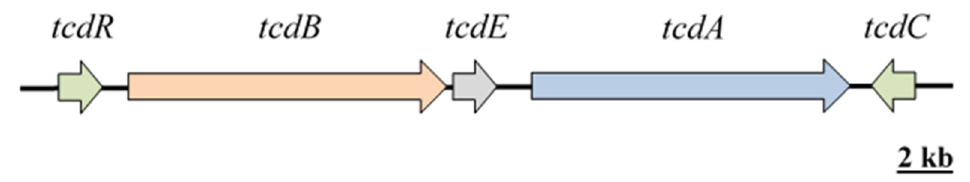
Figure 1. Illustration of the C. difficile Pathogenicity locus (PaLoc). Adapted from [65].